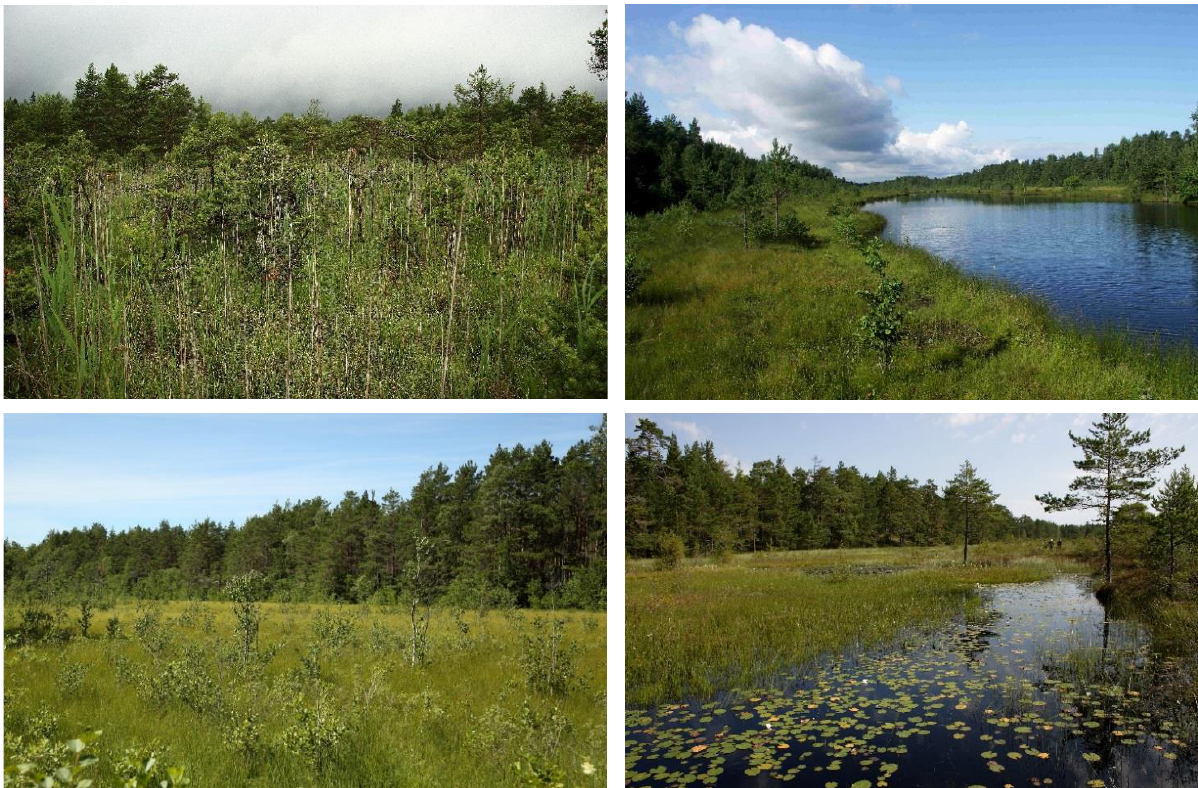
Figure 2. Overview of the calcareous spring fen (top left), Pēterezera lake with a sequence of rich fen to bog (top right), Kukšupe inter-dune rich fen (bottom left) and Imanta inter-dune poor fen (bottom right)